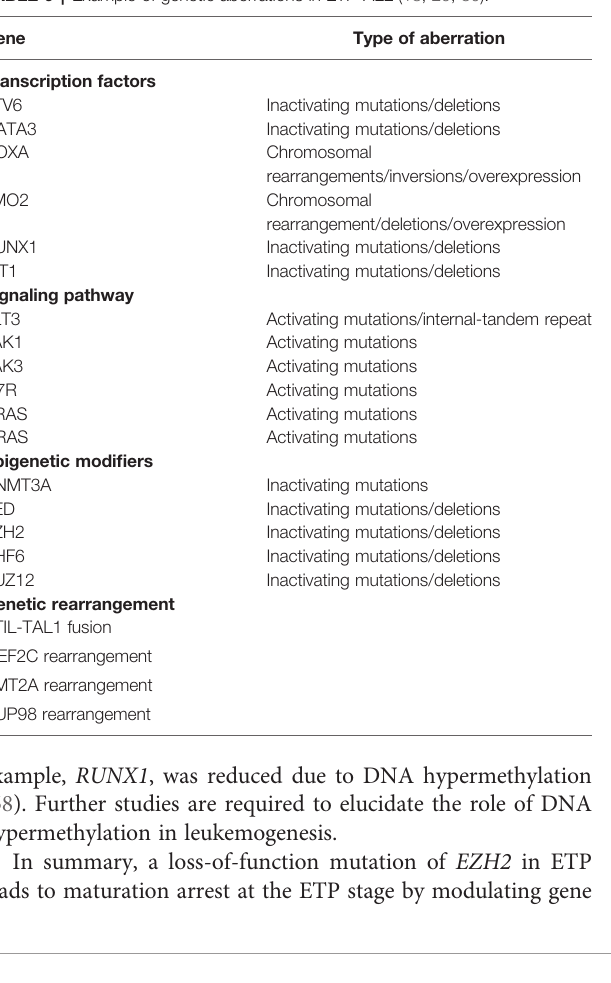
TABLE 6 | Example of genetic aberrations in ETP-ALL (18, 29,